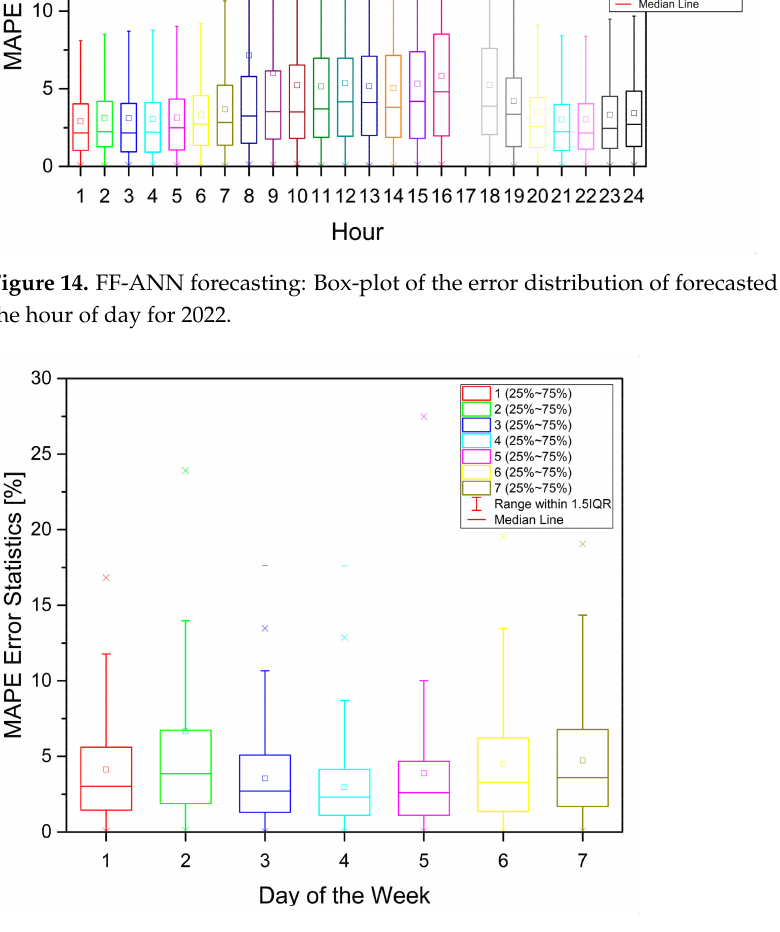
Figure 15. FF-ANN forecasting: Box-plot of the error distribution of forecasted load as function of the day of week for the year